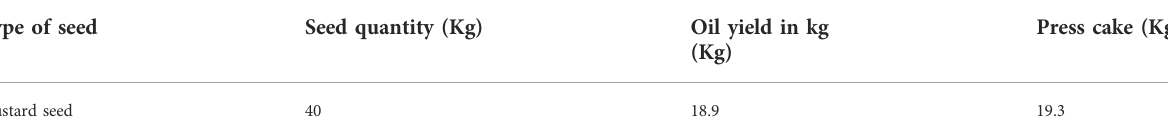
TABLE 2 Yield percentages of crude